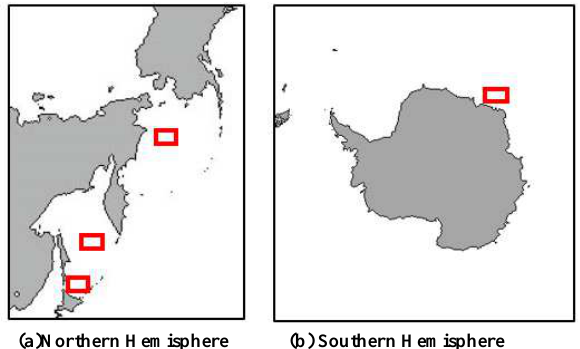
Figure 1. The location of the test